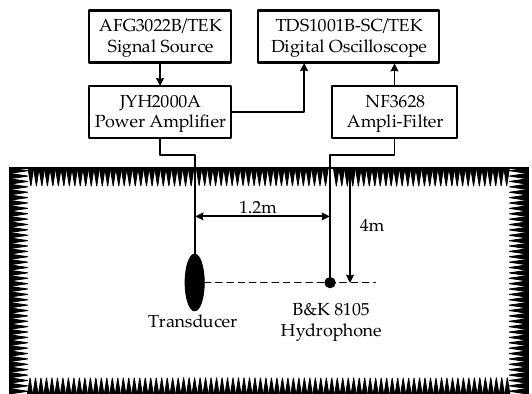
Figure 18. Diagram of testing system.